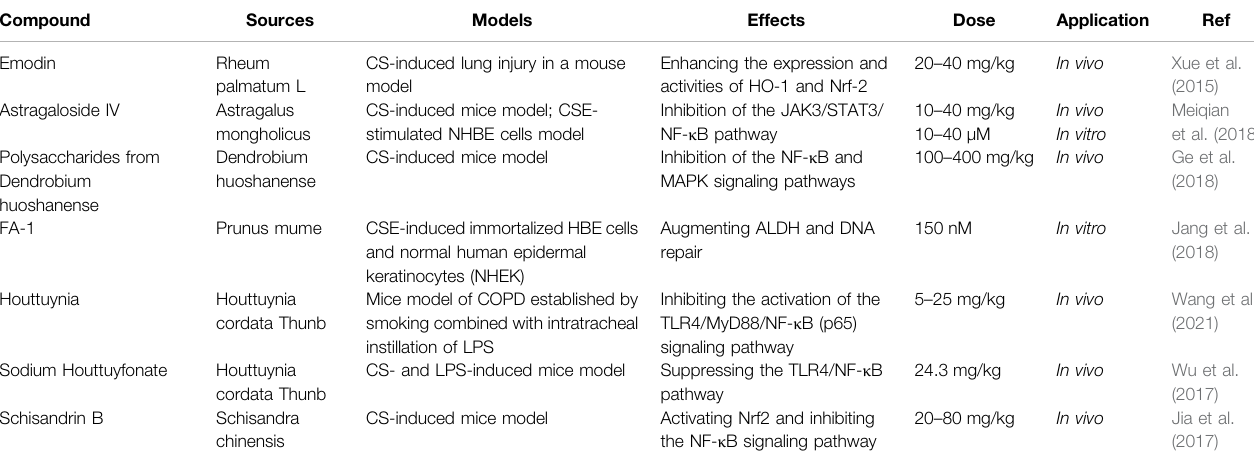
TABLE 10 | The effects of other compounds on